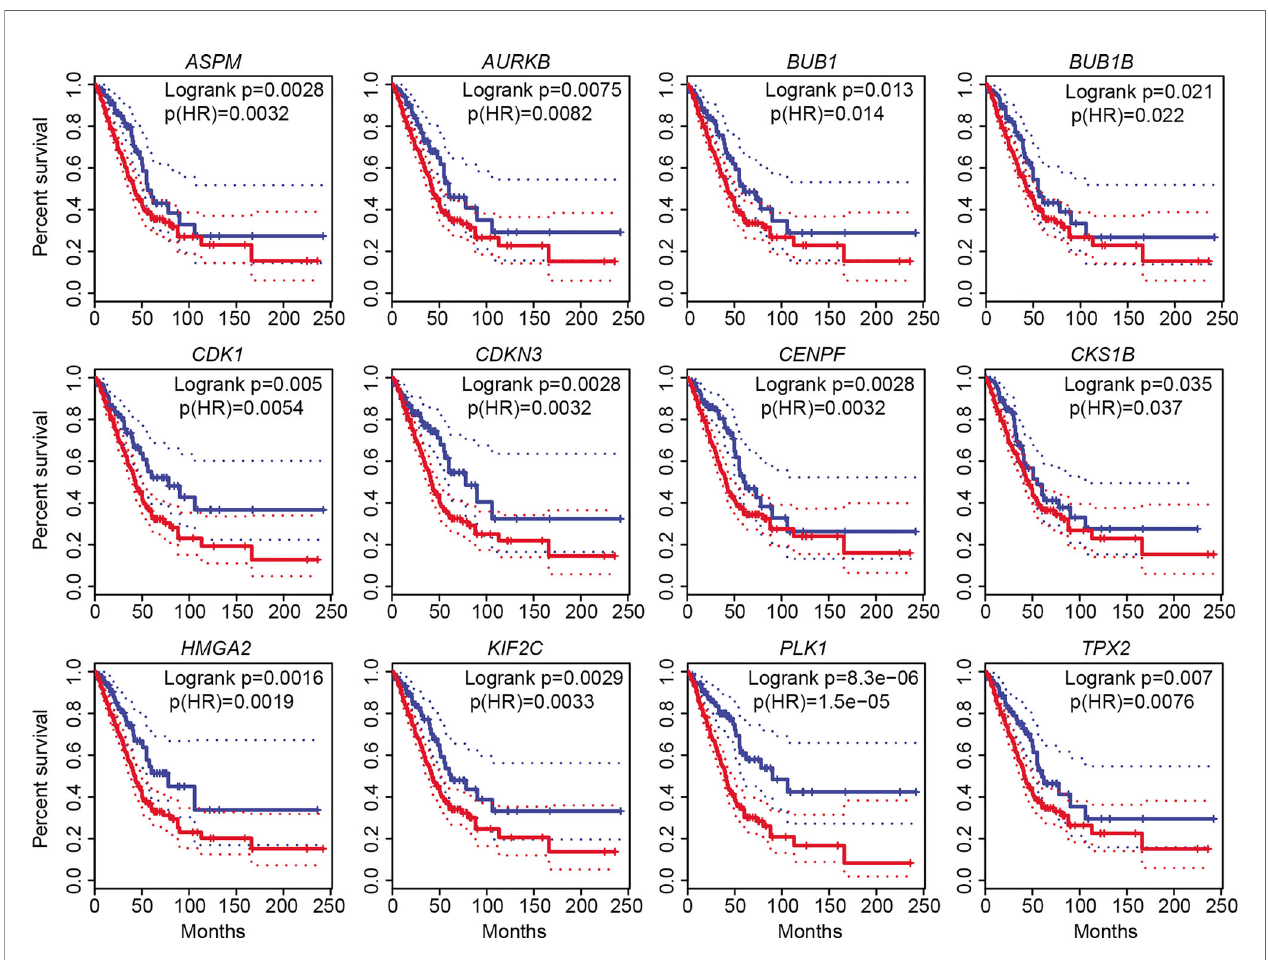
FIGURE 4 | Overall survival (OS) analysis of 12 increased DEGs involved in cell cycle, cell division, and cell proliferation. The high-expression group was represented by red colors, and the low-expression group was represented by blue colors. Both high and low cutoffs were set to 25%, n (high) = 359, n (low) = 120. HR, hazard